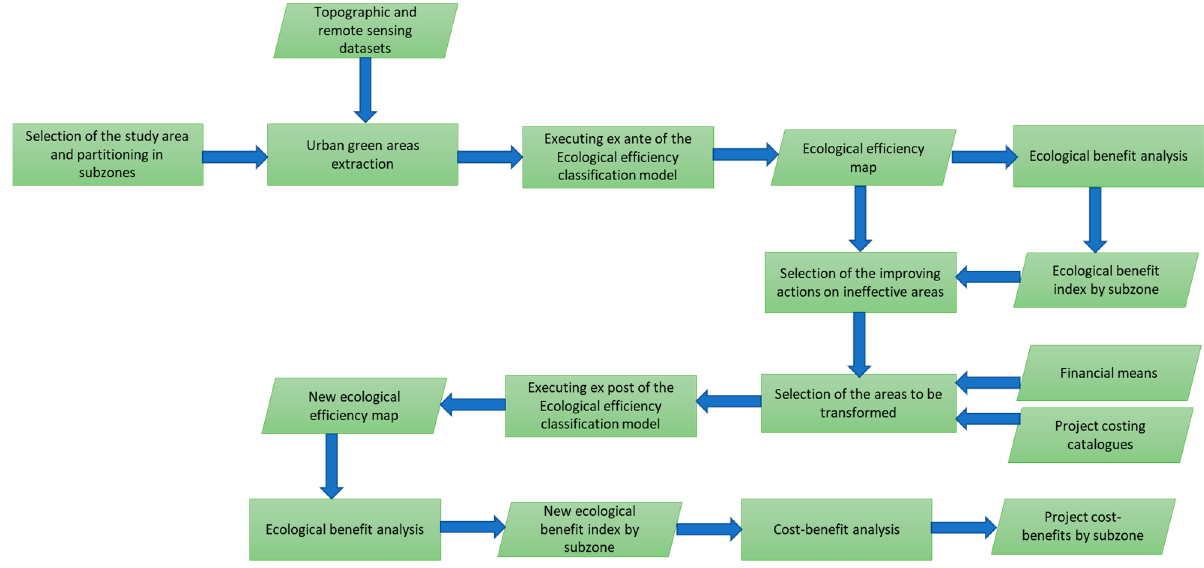
Figure 4. Diagram of the research framework.